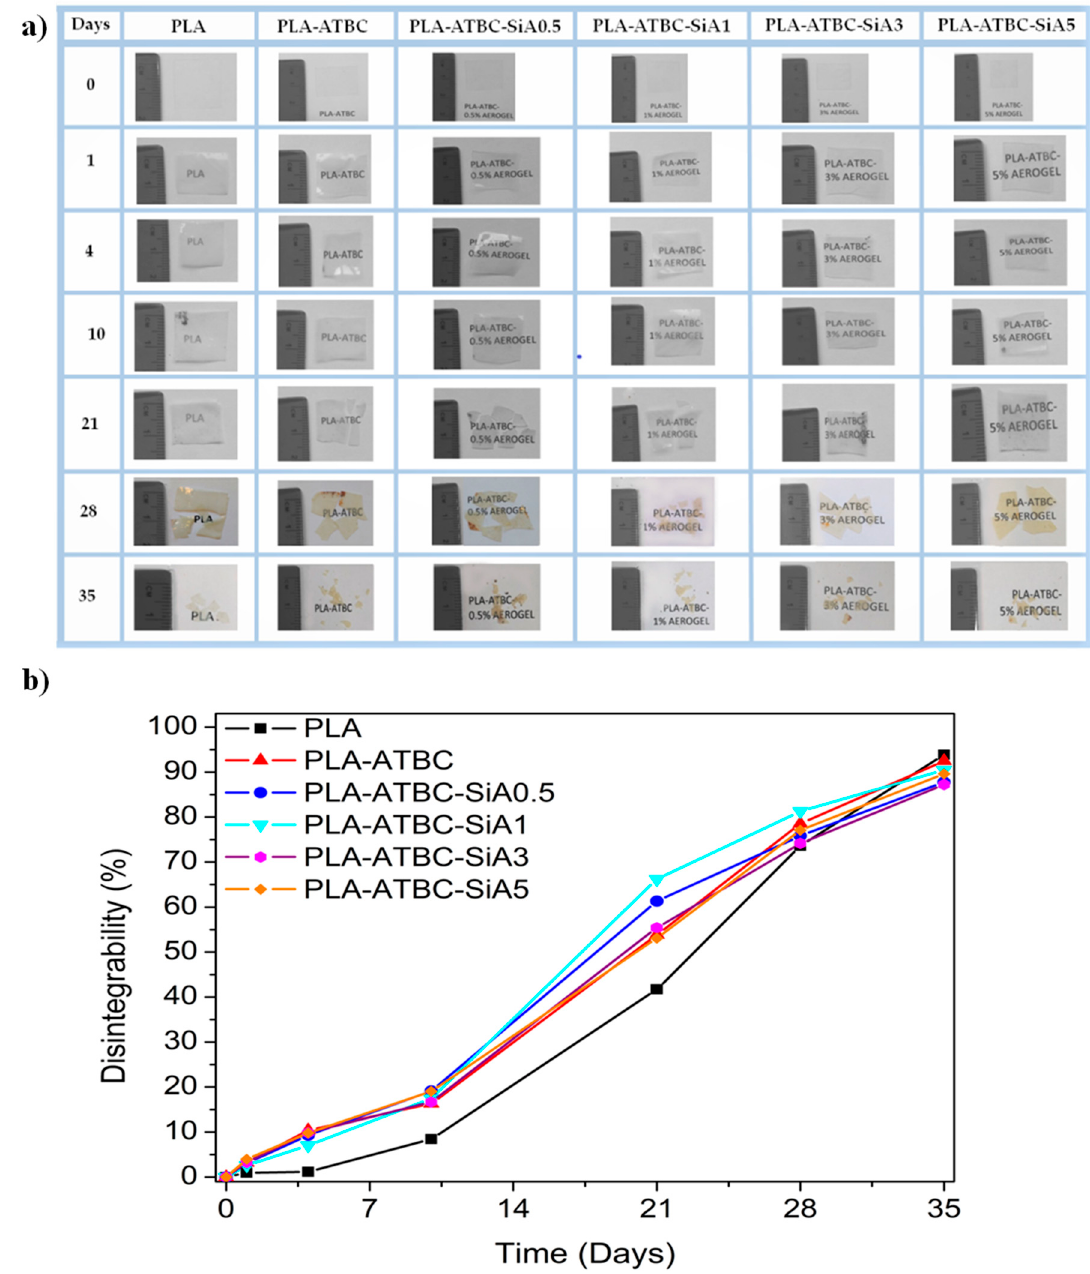
Figure 5. ( a ) visual aspect of film samples at different degradation times, ( b ) degree of disintegration under composting conditions as a function of time.